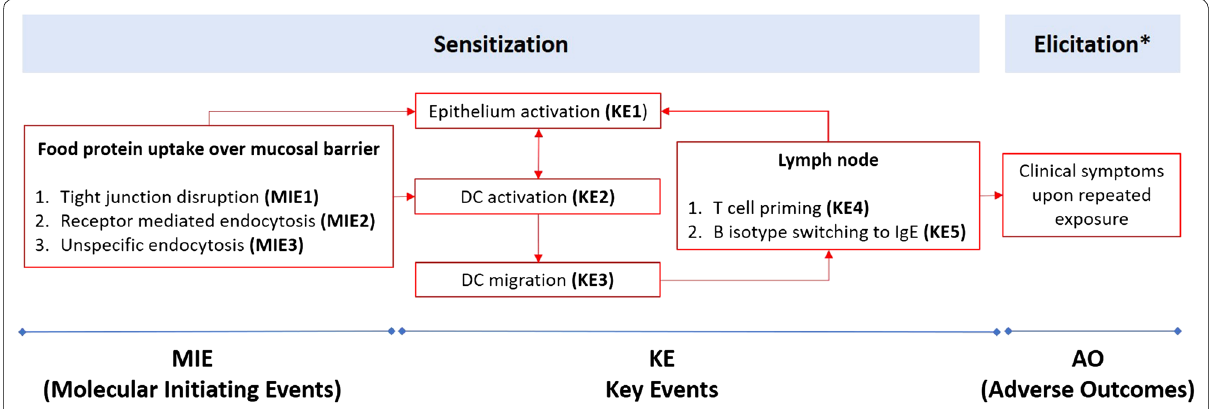
Fig. 1 Adverse Outcome Pathway for food